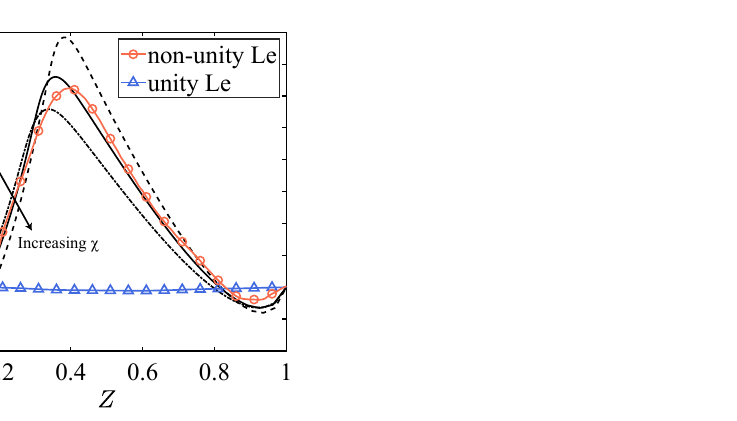
Figure 11. Differential diffusion parameter Z HC plotted over the mixture fraction space for two LES cases and laminar counterflow flames with non-unity Lewis numbers. Along the arrow’s direction, the dissipation rate of laminar counterflow flames increases, and the values of the scalar dissipation rate are the same as those in Figure 10.